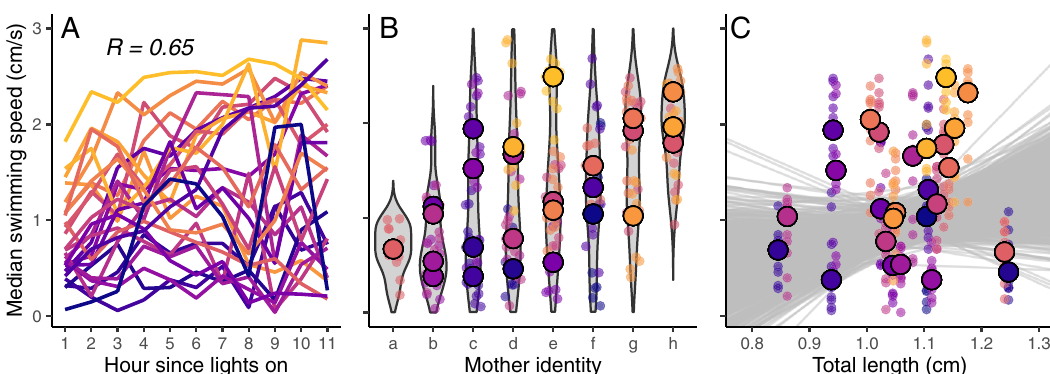
Fig. 2 | Individuality is present at day one after birth and is not explained by differencesinmaternalidentityorbodysize. Repeatabilityofmedianswimming speed at hourly intervals on the fi rst day after birth ( A ); each line represents one individual ( N =26). Maternal identity ( B ) did not explain variation in swimming speeds among individuals. Small and large points indicate the hourly (i.e. 11 data points per individual) and daily median swimming speeds, respectively, of indivi- dualsfromeachmotherondayoneafterbirth;seealsoTable1.Behaviorondayone